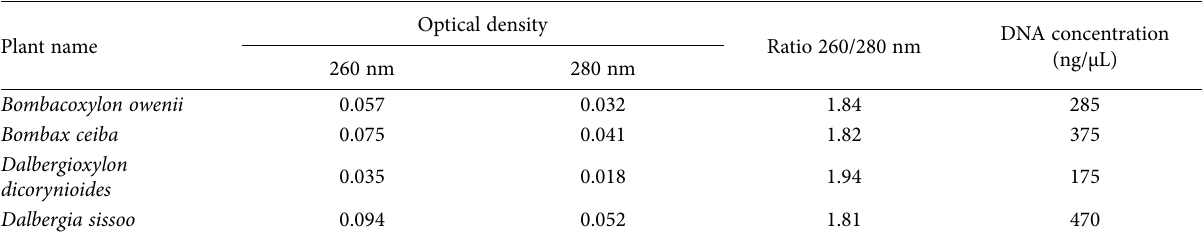
Table 3. Optical densities and concentrations of the DNA isolated from fossil and living specimens.